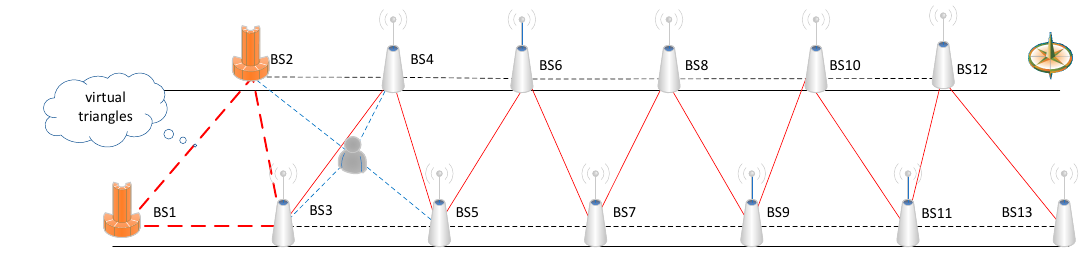
Figure 4. Diagram of building virtual triangles.